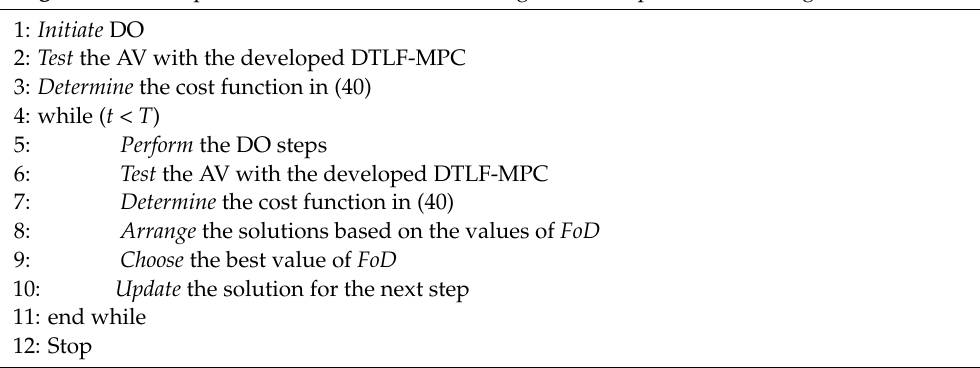
Algorithm 1. The pseudo-code of the DO for tuning the developed DTLF-MPC gains